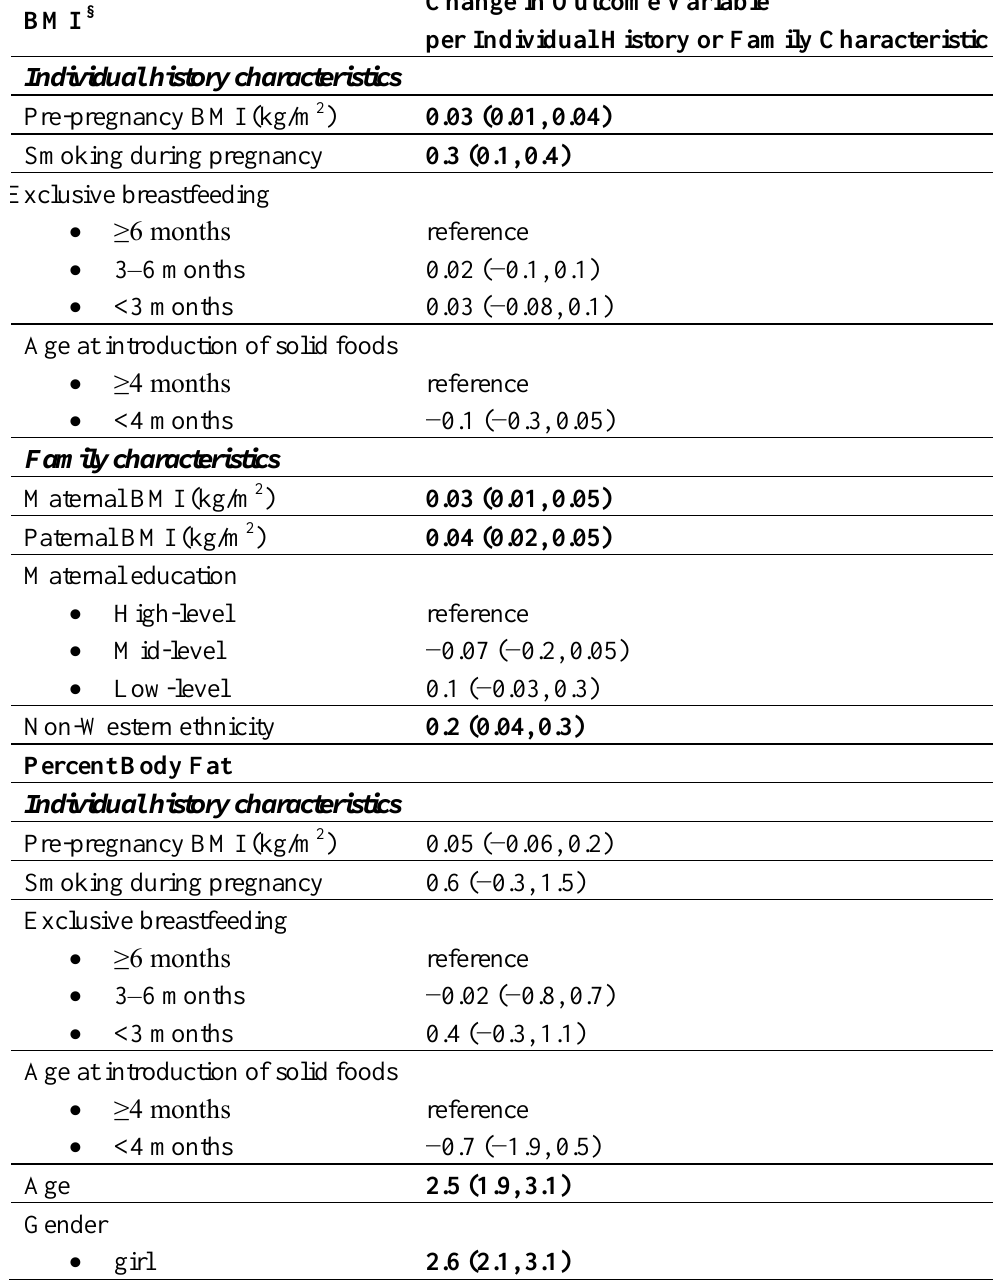
Table 3. Mixed model analyses on relationships between individual and familial characteristics, and child BMI, percent body fat and waist-to-height